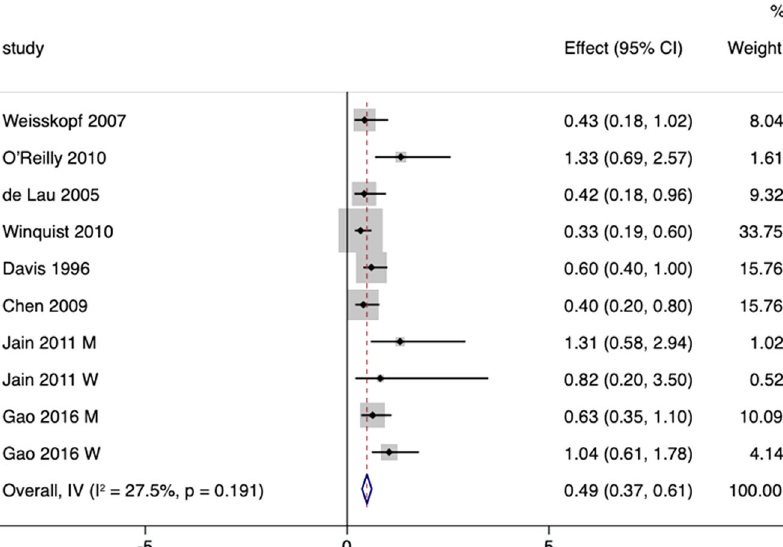
Fig. 2 RRs with 95% CIs from studies on the correlation between high urate concentration and risks of PD. The adjusted pooled estimate was 0.44 (95% CI 0.32 – 0.55).